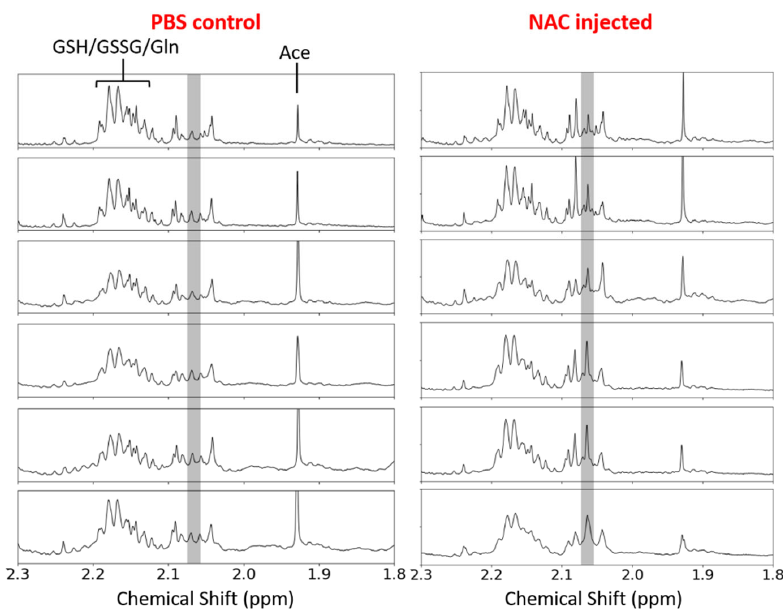
Figure 5. A close-up (1.8–2.3 ppm) of the 1 H-NMR spectra of aqueous mouse liver extracts from the test ( n = 6) and control ( n = 6) groups to show the presence and absence of the distinct NAC methyl proton singlet at ~2.06 ppm (shaded) in the test and control groups, respectively. The resonances of GSH, GSSG, glutamine (Gln) and acetate (Ace) were also identified for reference [34,35].